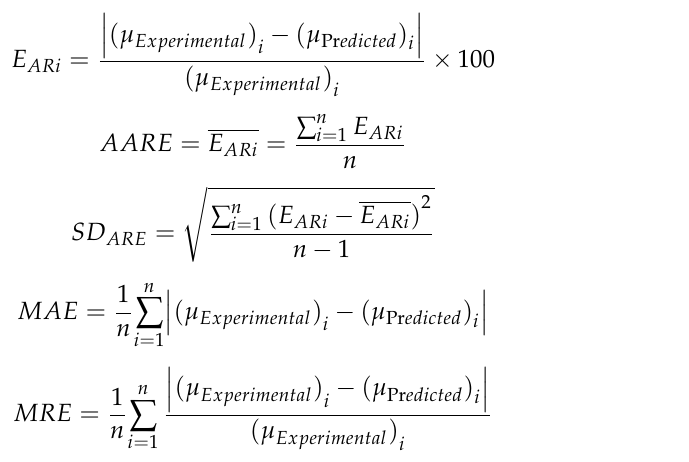
Figure 5. Neural Network Architecture.